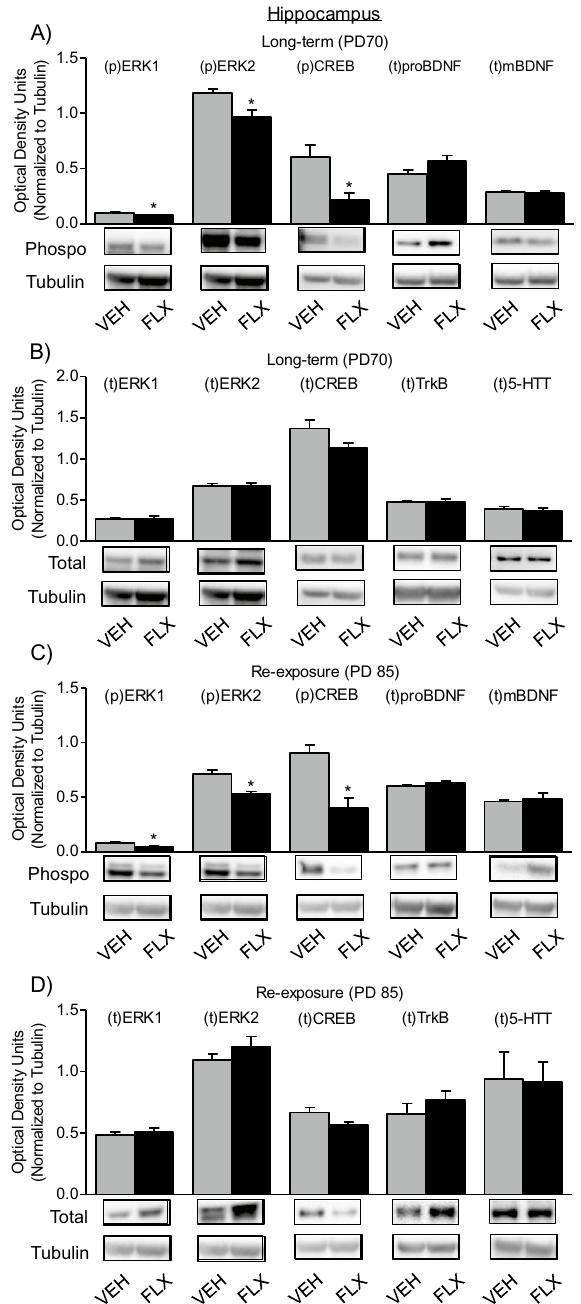
Figure 5. Long-term effects of juvenile FLX treatment, and its re-exposure in adulthood, on ERK1/2, CREB, BDNF TrkB, and 5-HTT proteins in the hippocampus of female C57BL/6 mice. ( A ) Adolescent FLX pretreatment (PD35-49) significantly decreased phosphorylated (p) ERK1, (p)ERK2, and (p)CREB without altering total (t) proBDNF or mBDNF at PD70 (Long-term), when compared to water (VEH)-treated controls. ( B ) No differences in (t)ERK1/2, (t)CREB, (t)TrkB, or (t)5-HTT were noted between the groups 21-days after adolescent FLX pretreatment. ( C ) Re-exposure to FLX in adulthood (PD70-84), in female mice with adolescent FLX history, decreased phosphorylated (p) levels of ERK1, ERK2, and CREB, with no differences in total proBDNF or mBDNF, 24 h after the end of treatment (PD85). ( D ) No differences in total ERK1/2, CREB, TrkB, or 5-HTT were observed on PD85, as a function of juvenile FLX exposure (PD35-49) and re-exposure in adulthood (PD70-84). Western blots of hippocampal tissue, with α-Tubulin as loading control, were performed under identical protocols. Representative images were cropped from different blots (Supplemental Figure S1). Data are presented as mean ± SEM. * p <